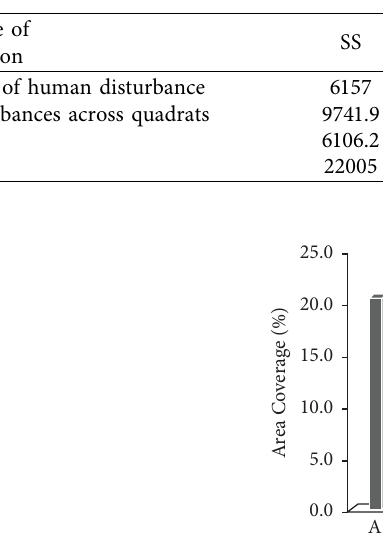
Table 8: ANOVA results determining the types of human disturbance and disturbances across quadrats number inside the church forest ( P < 0 . 05).